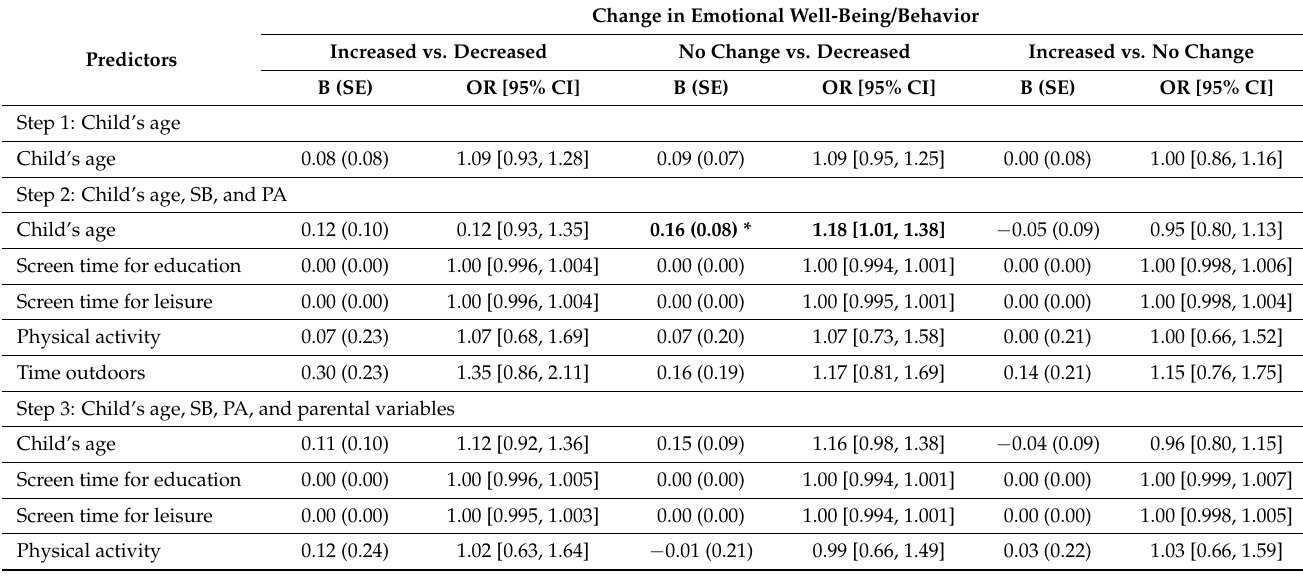
Table 4. Multinomial regression models predicting changes in children’s emotional